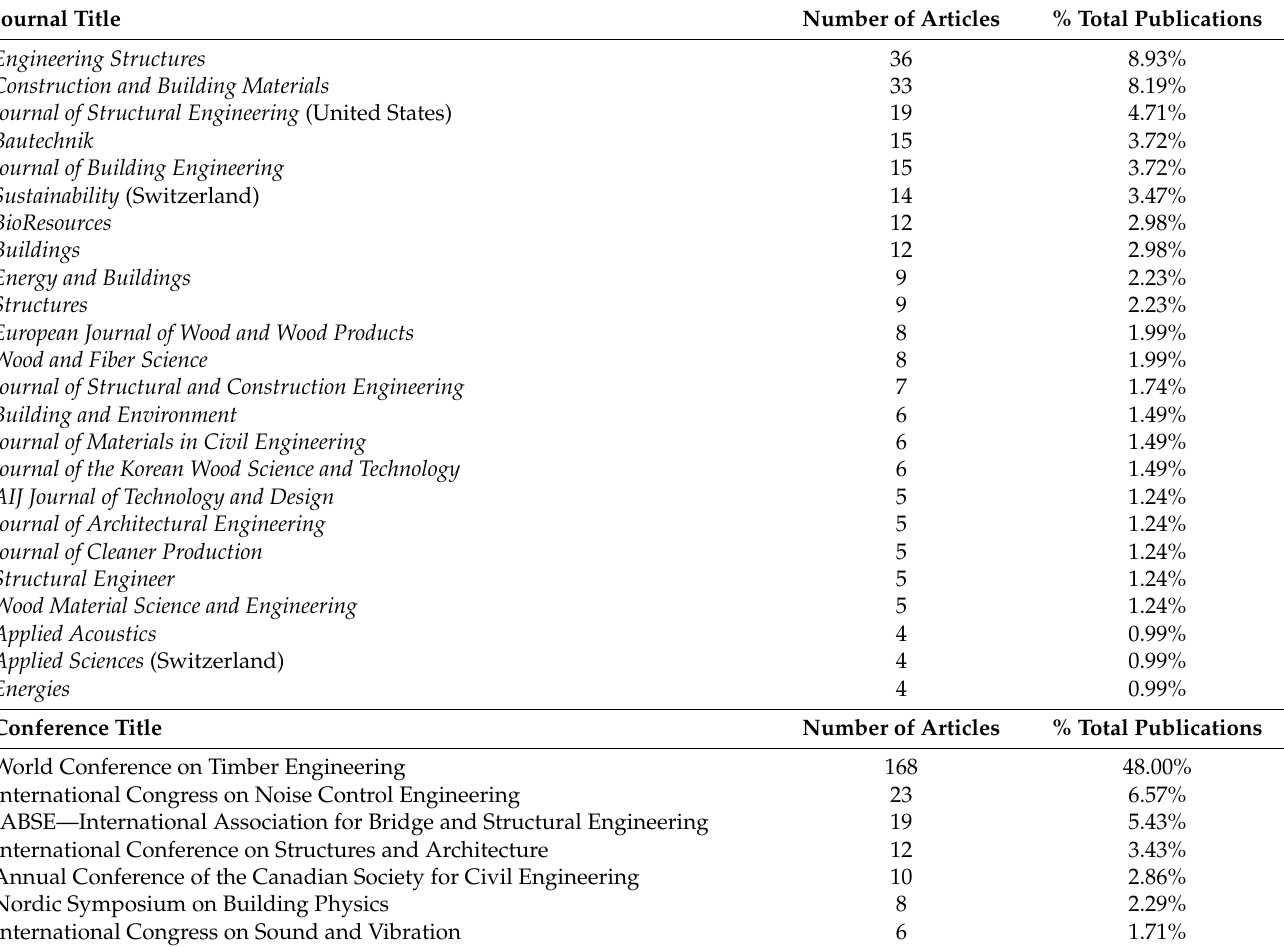
Table 1. List of most broadly read academic journals and conference proceedings from January 2006 to March 2022 that had publications related to cross-laminated timber in